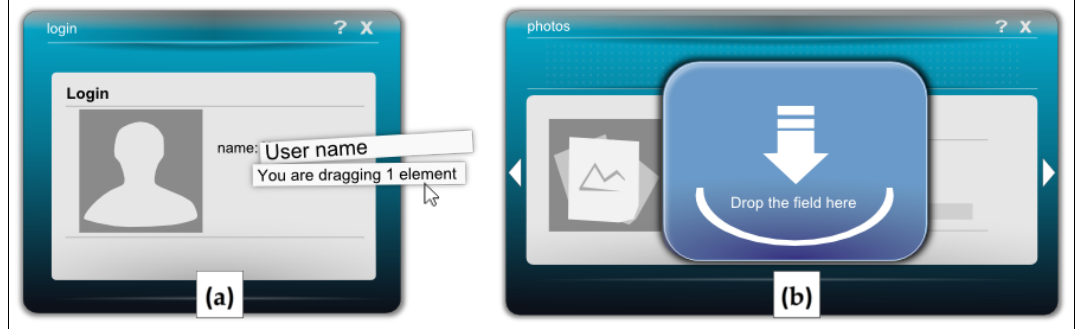
Figure 6. Example of user feedback while dragging a field from a widget into another. The ( a ) part shows the information displayed about the data field, while the ( b ) part shows the environment suggestion (which may be more than one) for dropping the selected